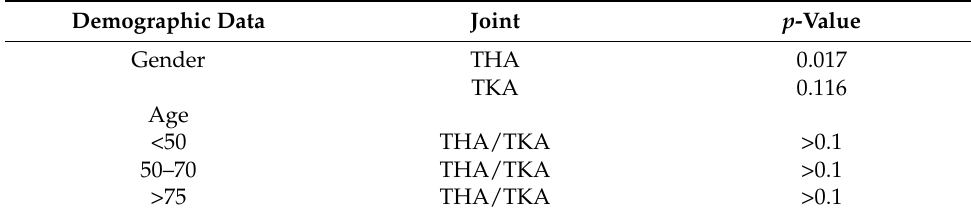
Table 3. Demographic data for hip and